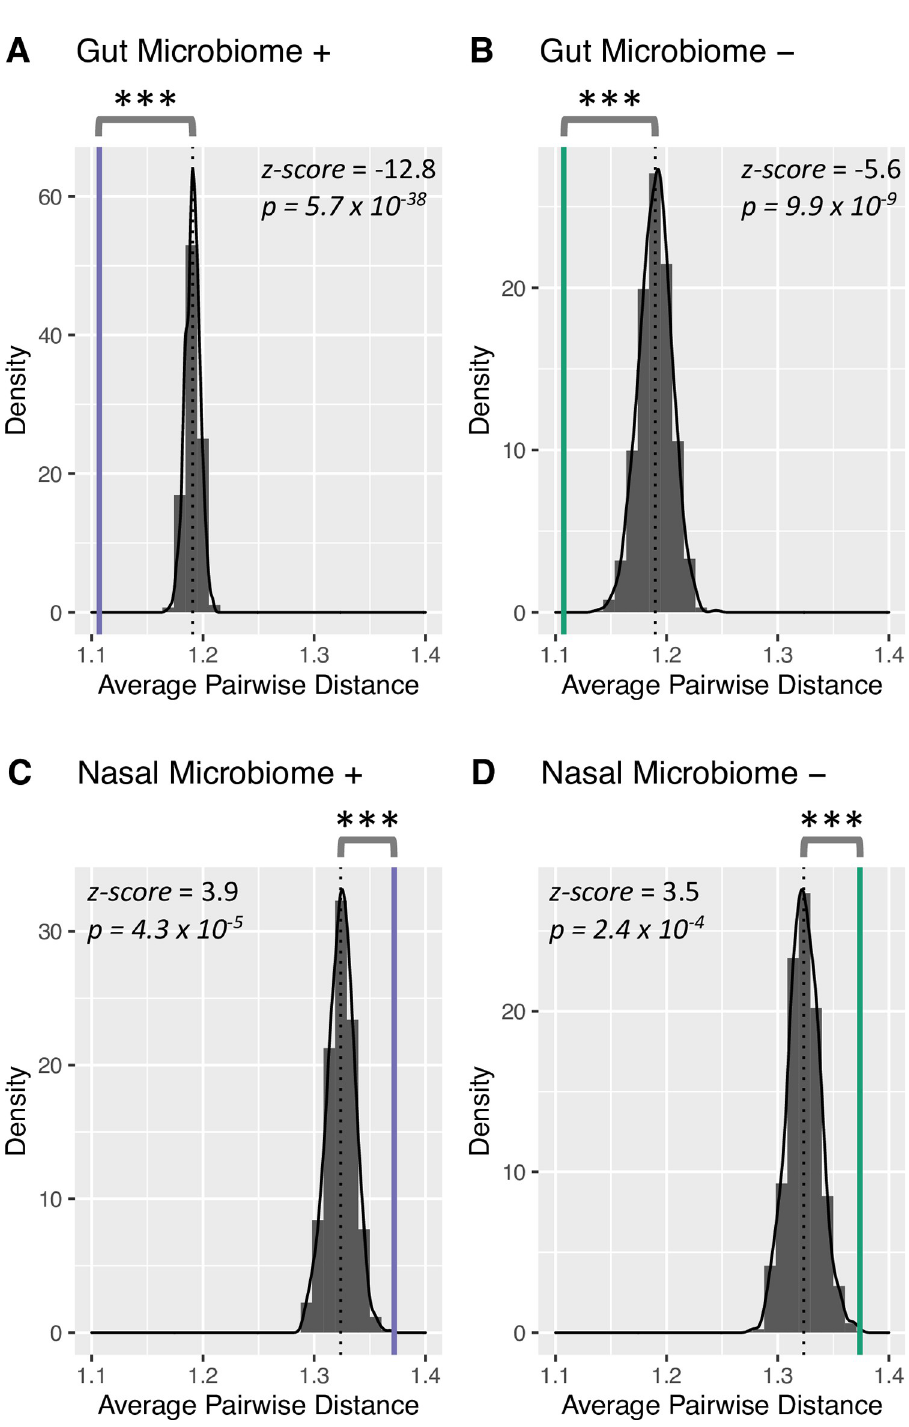
Fig 2. Gut microbiome features significantly associated with clinical signs show evidence of phylogenetic clustering while nasal microbiome features show evidence of phylogenetic overdispersion. Microbial features that were significantly associated with clinical signs were separated into four groups: gut microbiome features that positively (A) or negatively (B) associated with clinical signs, and nasal microbiome features that positively (C) or negatively (D) associated with clinical signs. For each figure, the observed average pairwise distance is indicated by a vertical line. The null expectation of the average pairwise distance between two random nodes observed on the phylogenetic tree is indicated by the black dotted vertical line. The null expectation average pairwise distance was generated from a bootstrapped set of random samplings of phylogenetic distances ( N = 1,000), and is indicated by